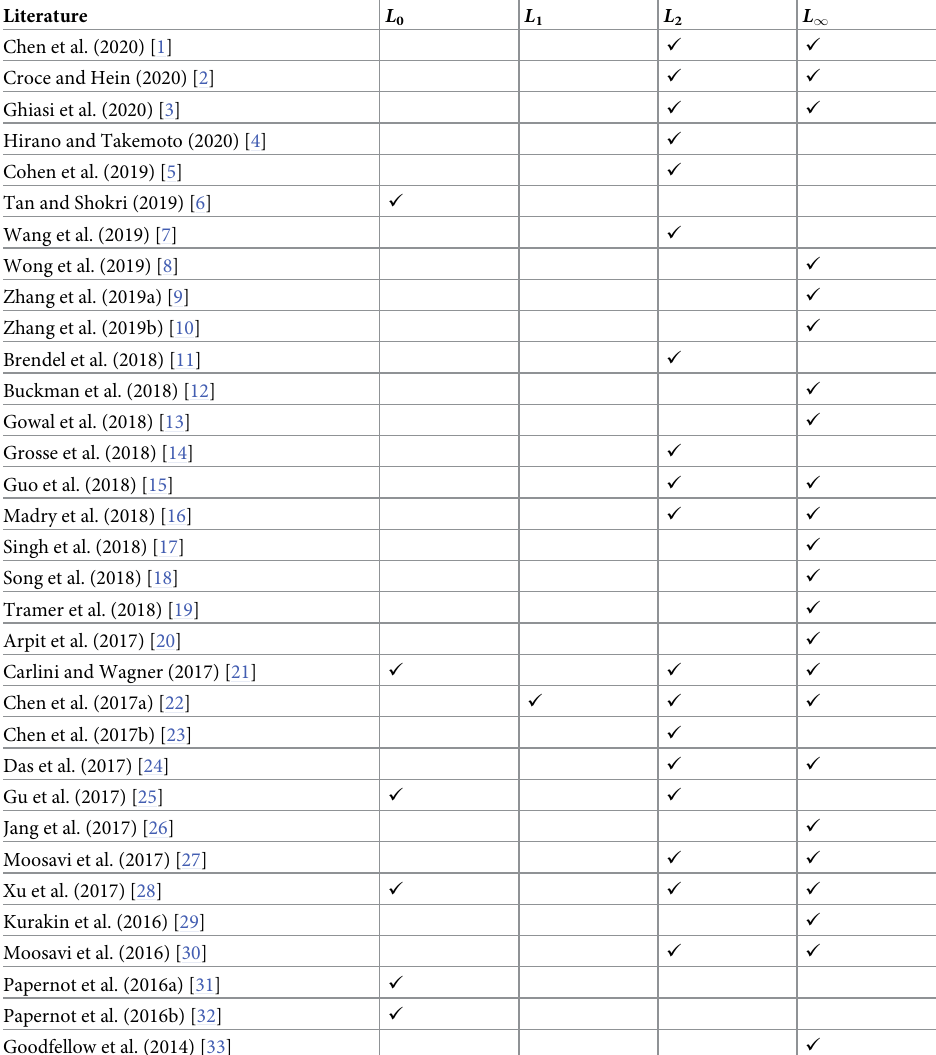
Table 2. Norms used in robustness assessment in other